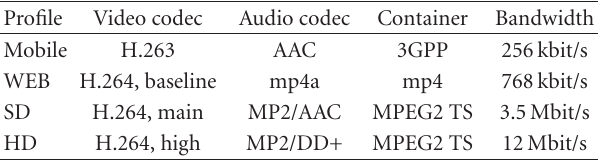
Table 1: Examples of codec profiles for